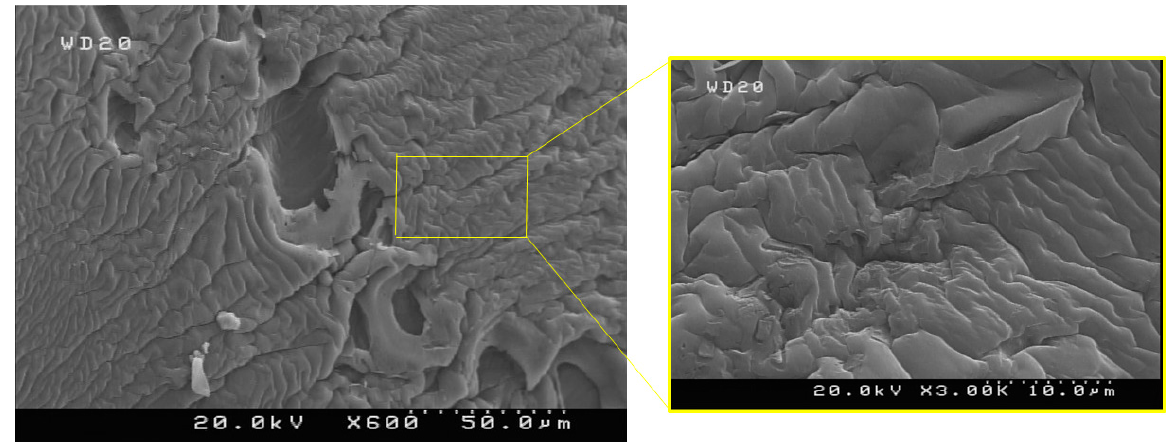
Figure 5. FESEM micrographs of freeze-dried homopolymer hydrogel of PAAm.